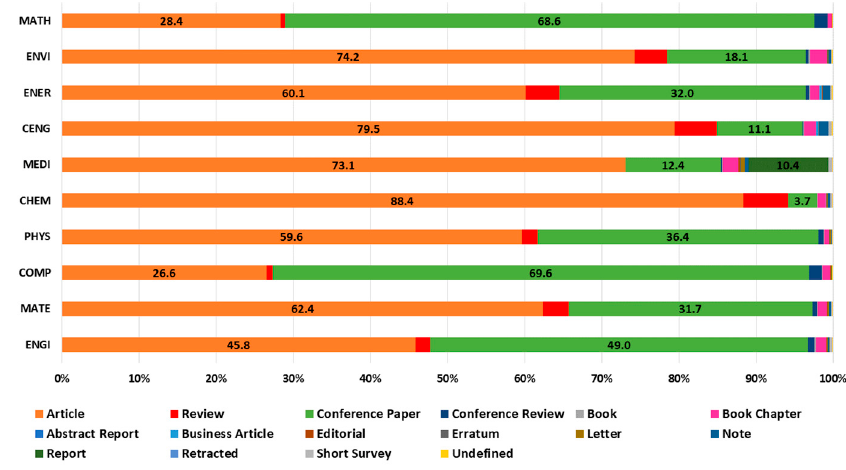
Figure 4. Distribution by publication type according to the scientific category.